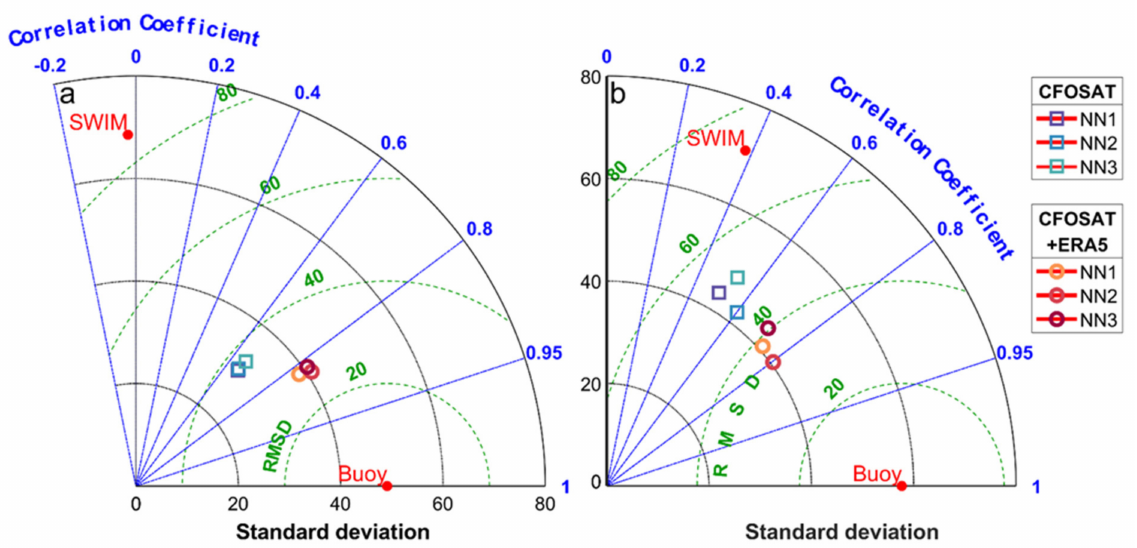
Figure 11. Taylor diagrams of the calibration ( a ) and validation ( b ) results for the three-stage NN models (NN1, NN2, and NN3) using the typical sampling method (former 75% for calibration and latter 25% for validation); squares represent the results in which only CFOSAT parameters (Table 1) were used, while circles represent the results in which ERA5 parameters (Tables 1 and 2) were additionally included. RMSD in the Taylor diagram indicates the centered pattern root-mean- square